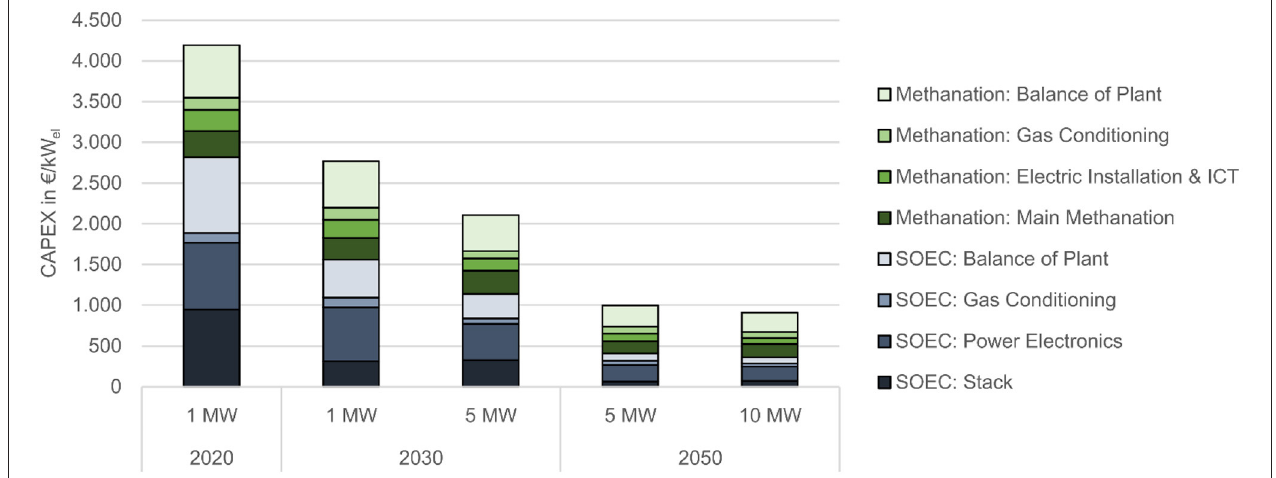
FIGURE 3 | CAPEX development of the power-to-gas system due to technological learning and scaling effects.